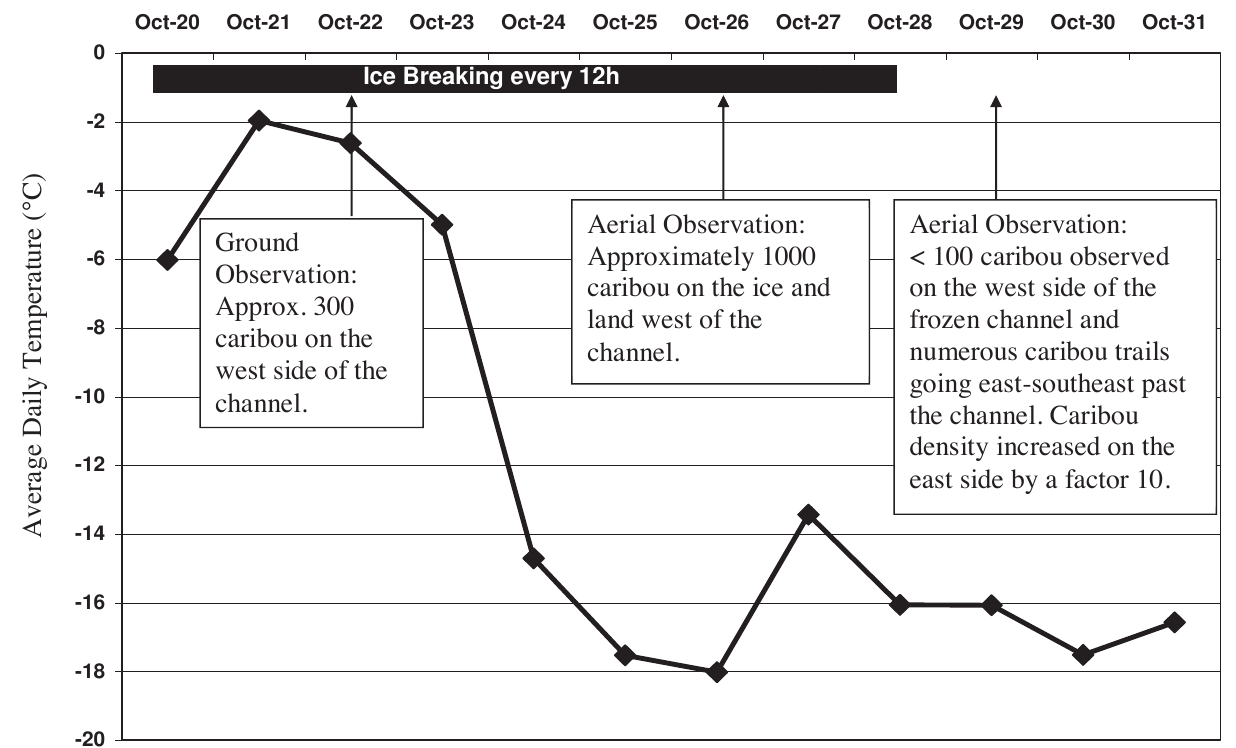
Figure 3. Chronology of observed events and average daily air temperature at Cambridge Bay, NU (from Environment Canada,